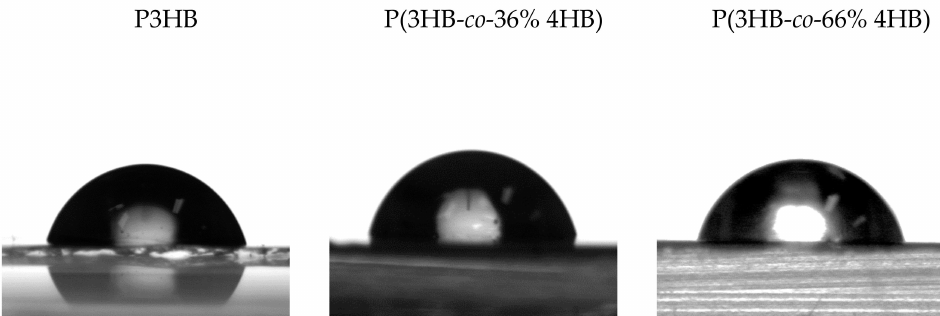
Figure 3. Images from water contact angle measurements representing high hydrophobicity of all tested films–P3HB, P(3HB- co -36 mol.% 4HB) and P(3HB- co -66 mol.%